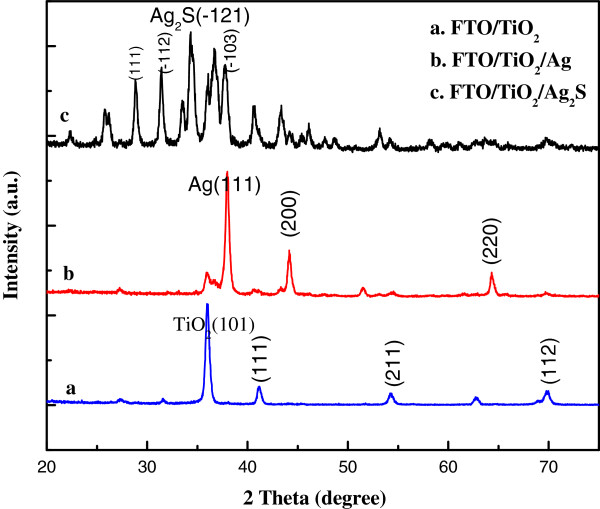
XRD patterns. FTO/TiO2 (a), FTO/TiO2/Ag (b), and FTO/TiO2/Ag2S (c) electrodes.